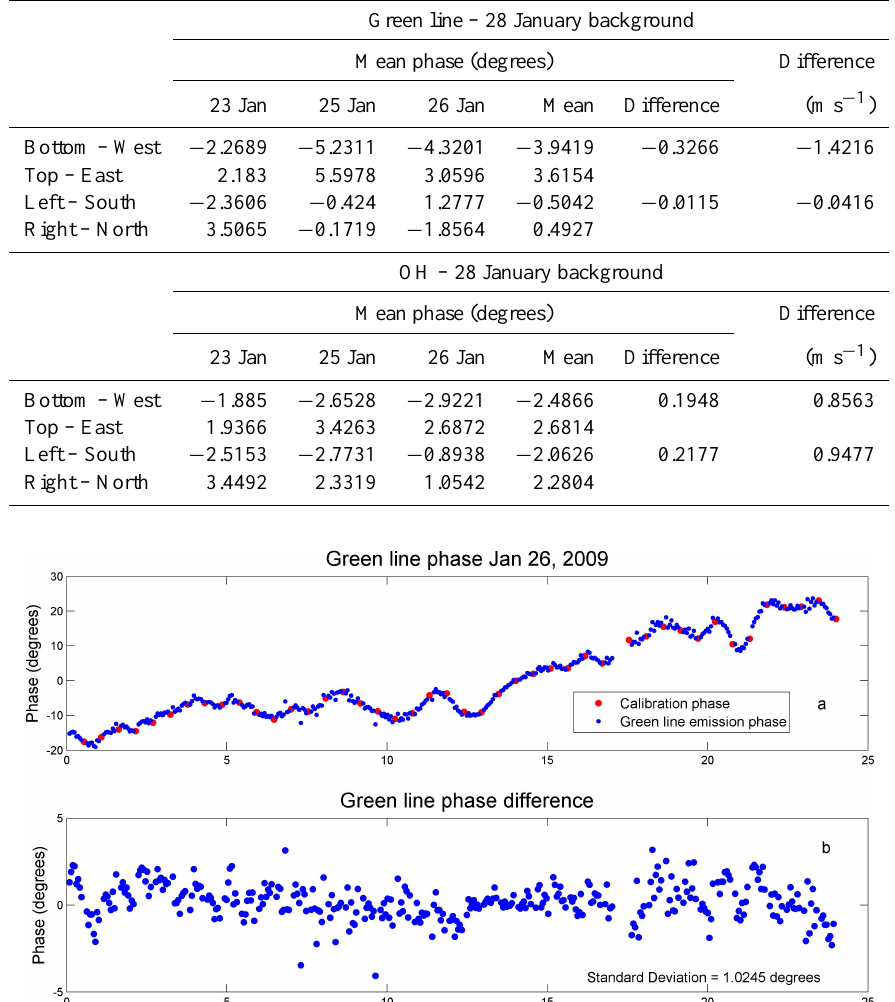
Table 1. Comparisons of the mean differences of the daily averages of the opposite sight directions for the green-line and OH emissions using the 28 January 2009 background phase.